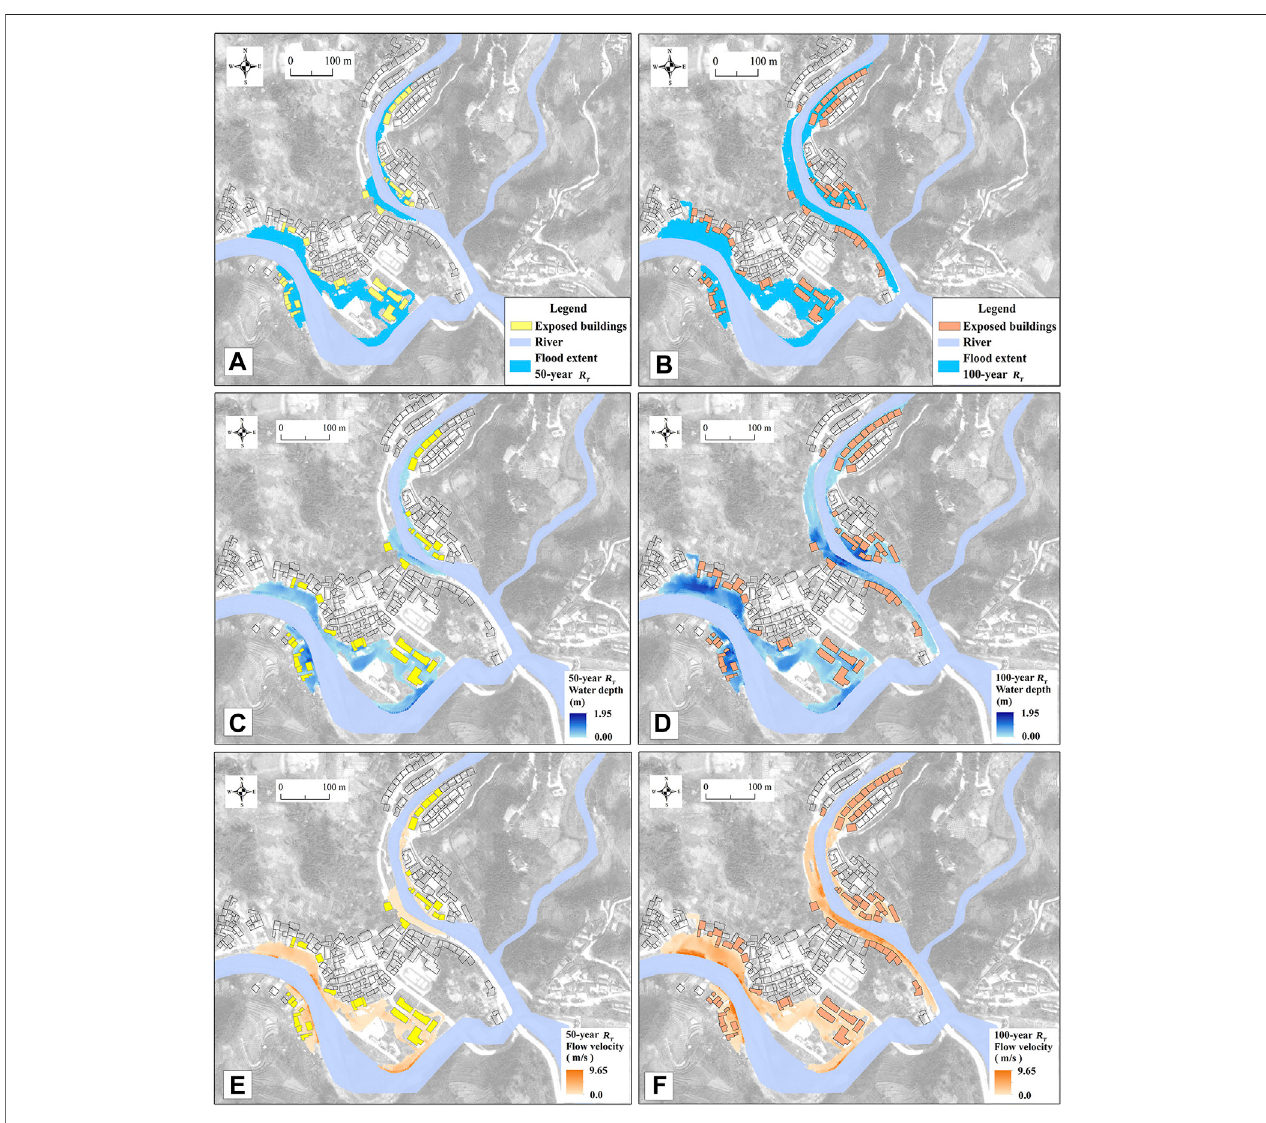
FIGURE 8 | Flood inundation results. (A) and (B) are the maximum inundation extent of fl ood with 50-year and 100-year R T , (C) and (D) are the maximum water depth of fl ood with 50-year and 100-year R T , (E) and (F) are the maximum fl ow velocity of fl ood with 50-year and 100-year R T .